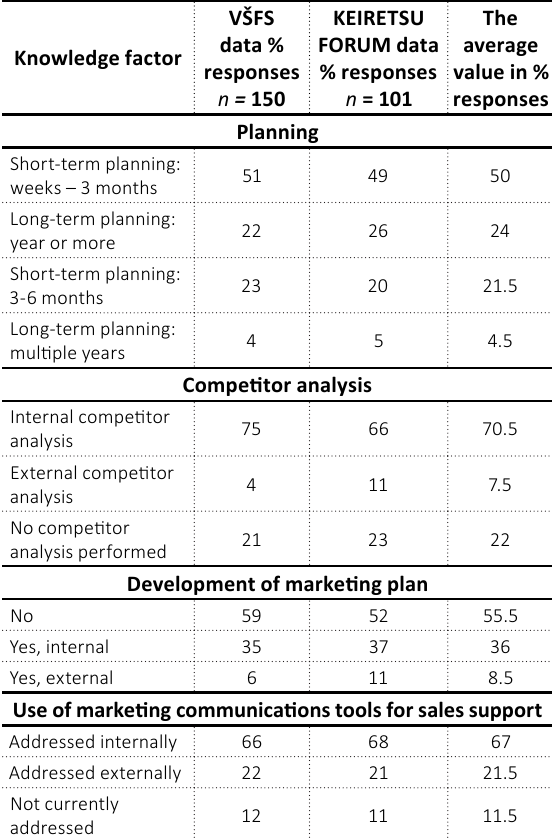
Table 6. View of startups on planning and executing marketing activities – the factor of applying knowledge in the area of